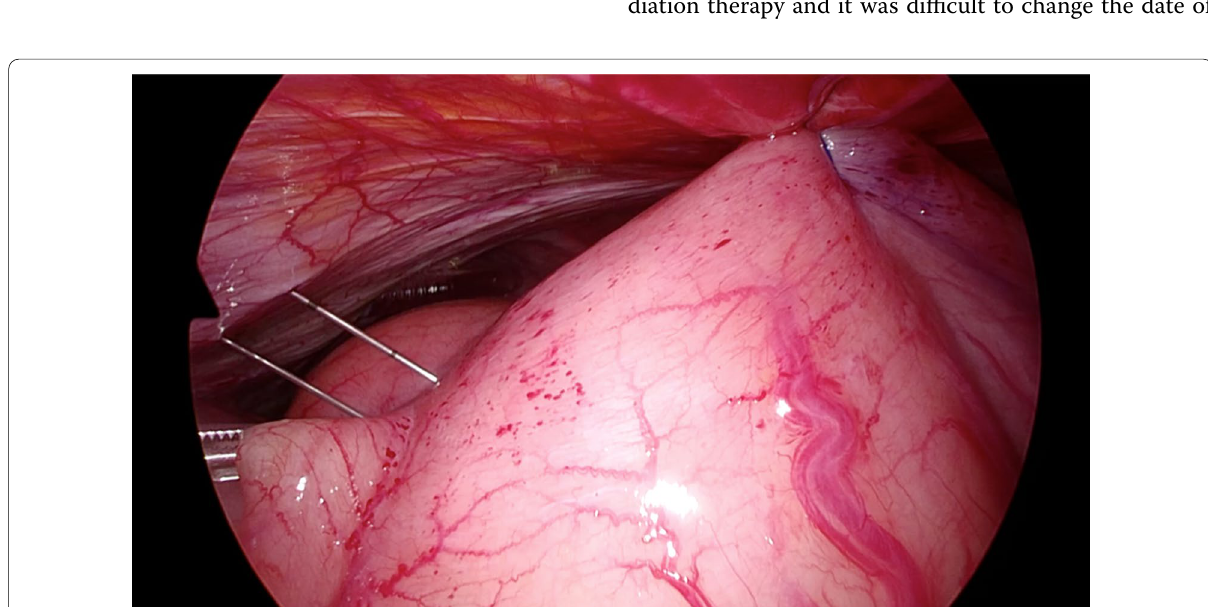
Fig. 4 The gastric antrum was fixed to the abdominal wall using a Funada-style loop gastropexy